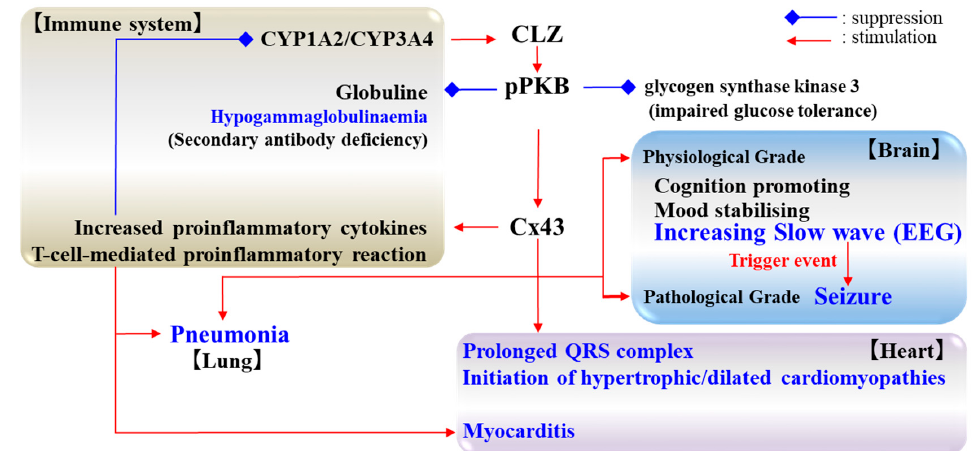
Figure 3. The proposed hypothesis of the pathomechanisms of clinical efficacy and severe adverse reactions of CLZ. Electroencephalogram (EEG).